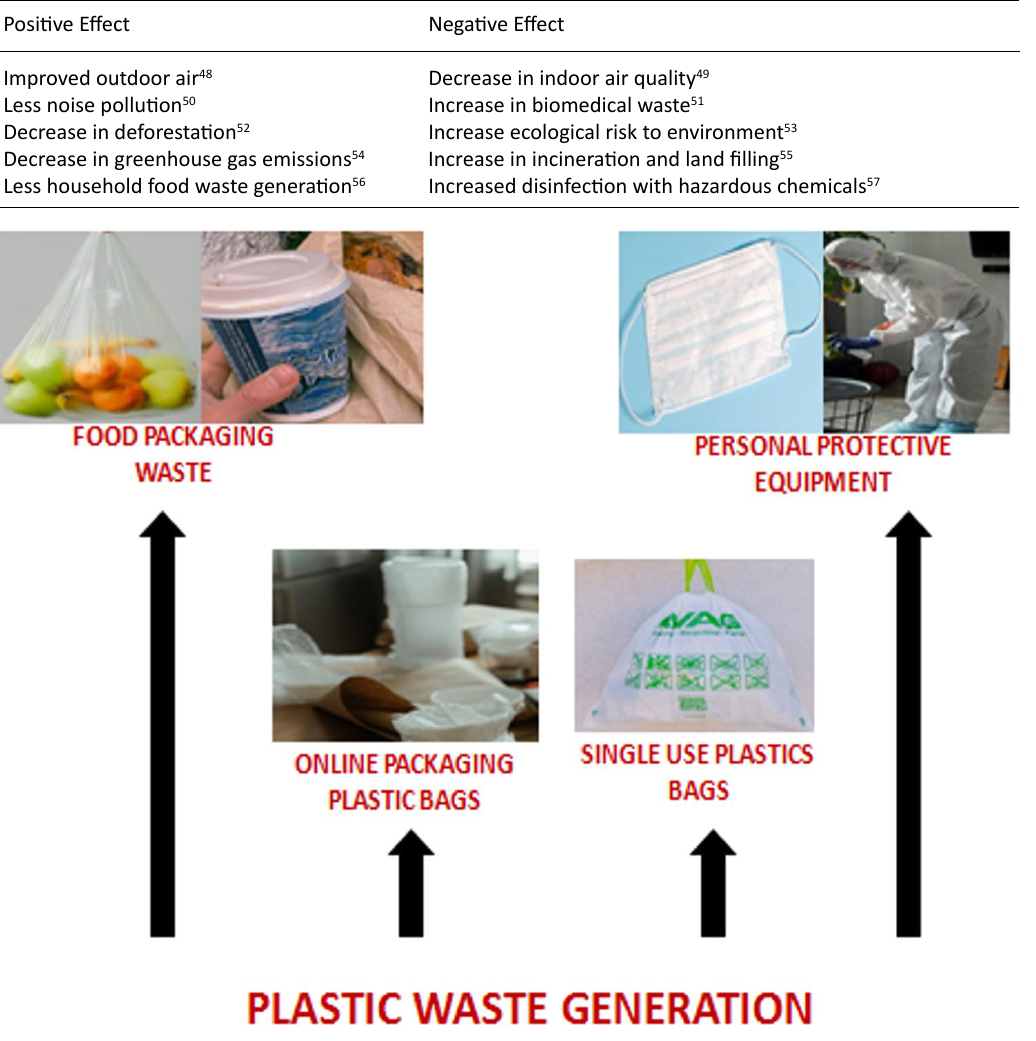
Fig. 2. Plastic waste produced from COVID-19 pandemic.